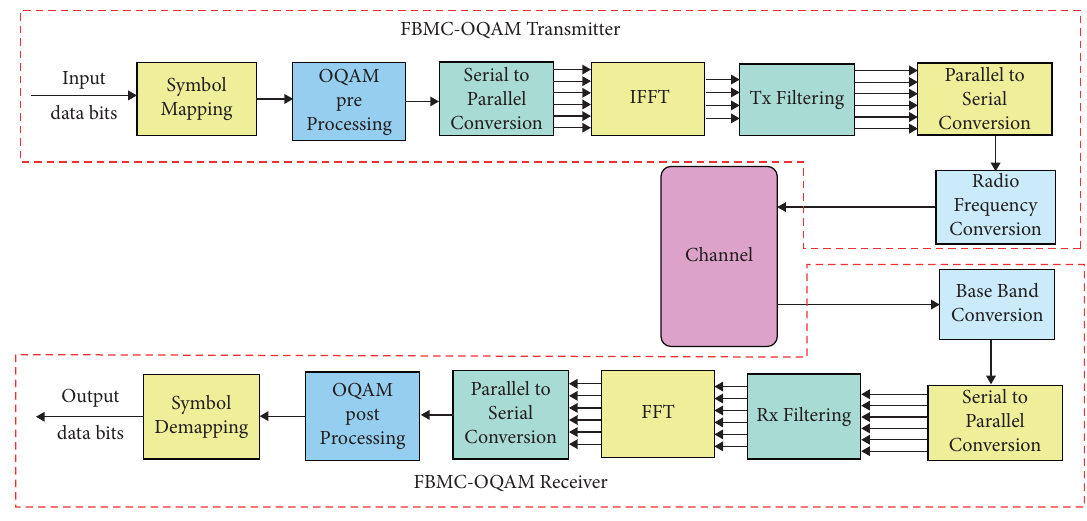
Figure 5: Filter bank multicarrier with ofset quadrature amplitude modulation